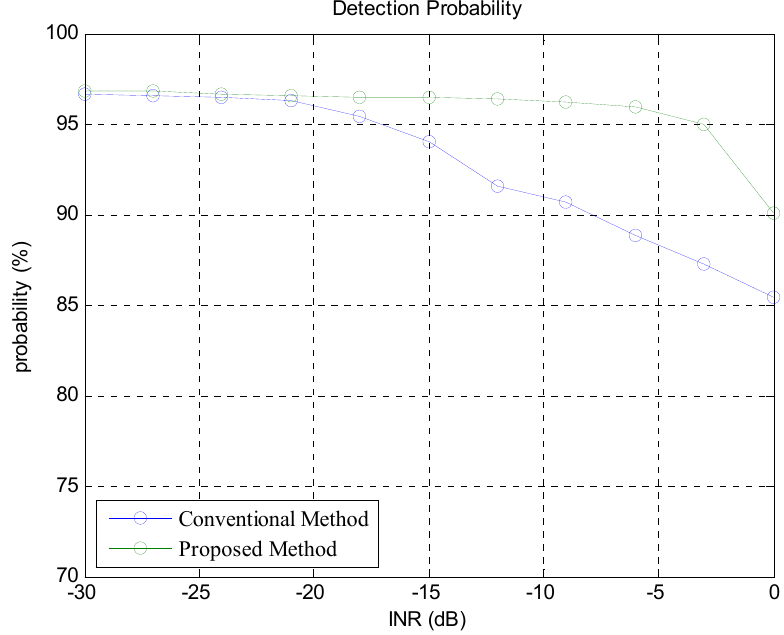
Figure 8. Detection probability of the proposed and conventional methods.